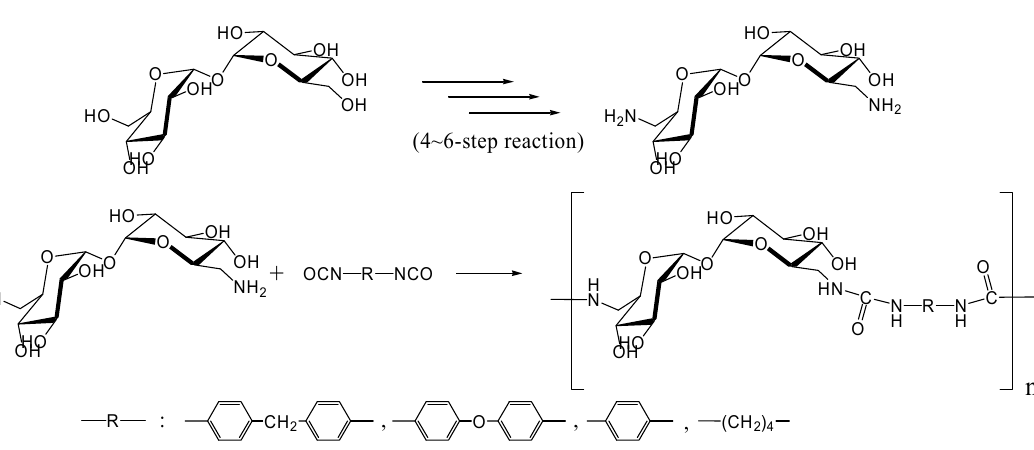
Figure 12. Synthesis of trehalose-based